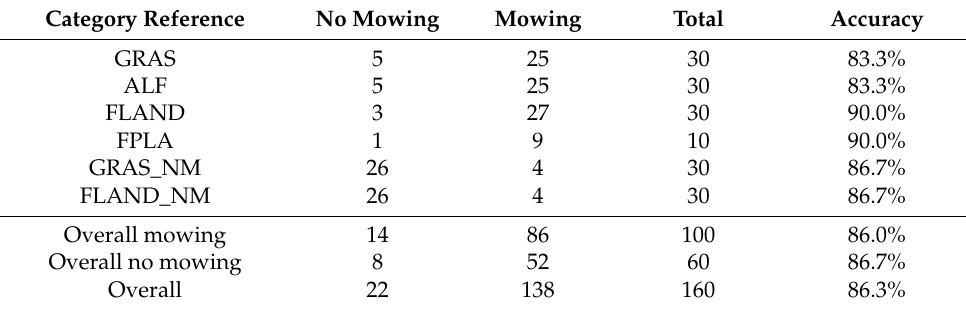
Table 4. Accuracy analysis of mowing detection for various crop classes.